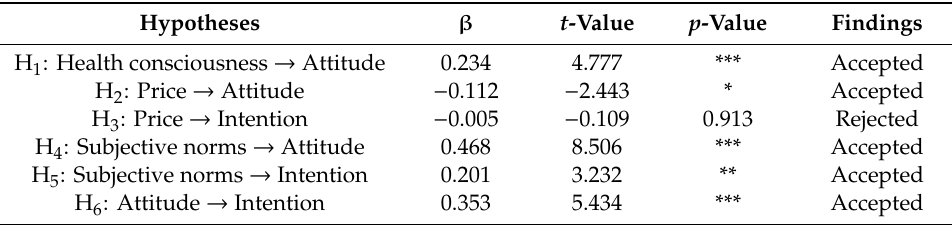
Table 5. Path Analysis and